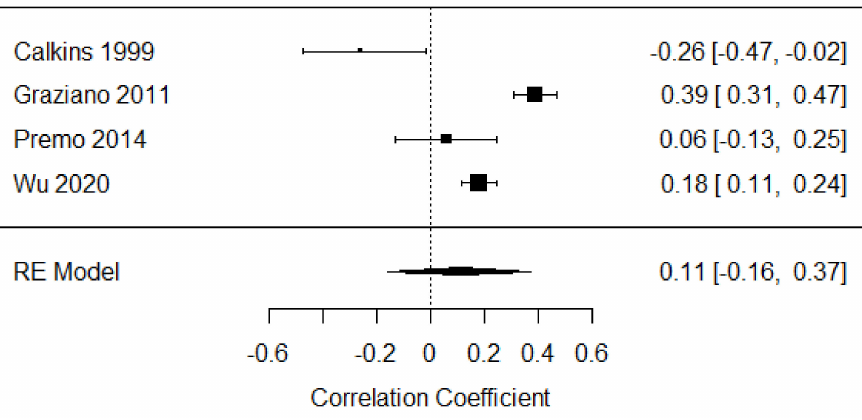
Figure 8. Forest plot of year 3 parent-focused strategies. Note: RE = Random-Effects